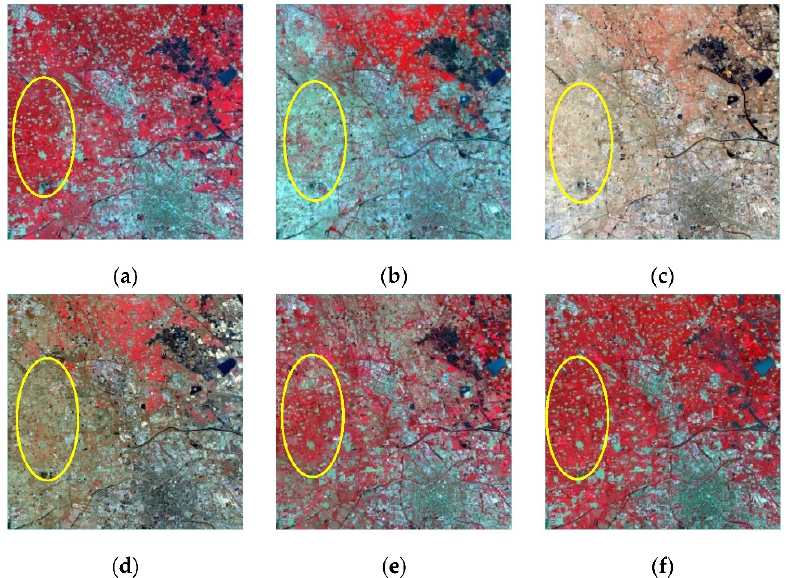
Figure 10. Landsat images from the Tianjin dataset reflecting changes in urban phenology. Dates: